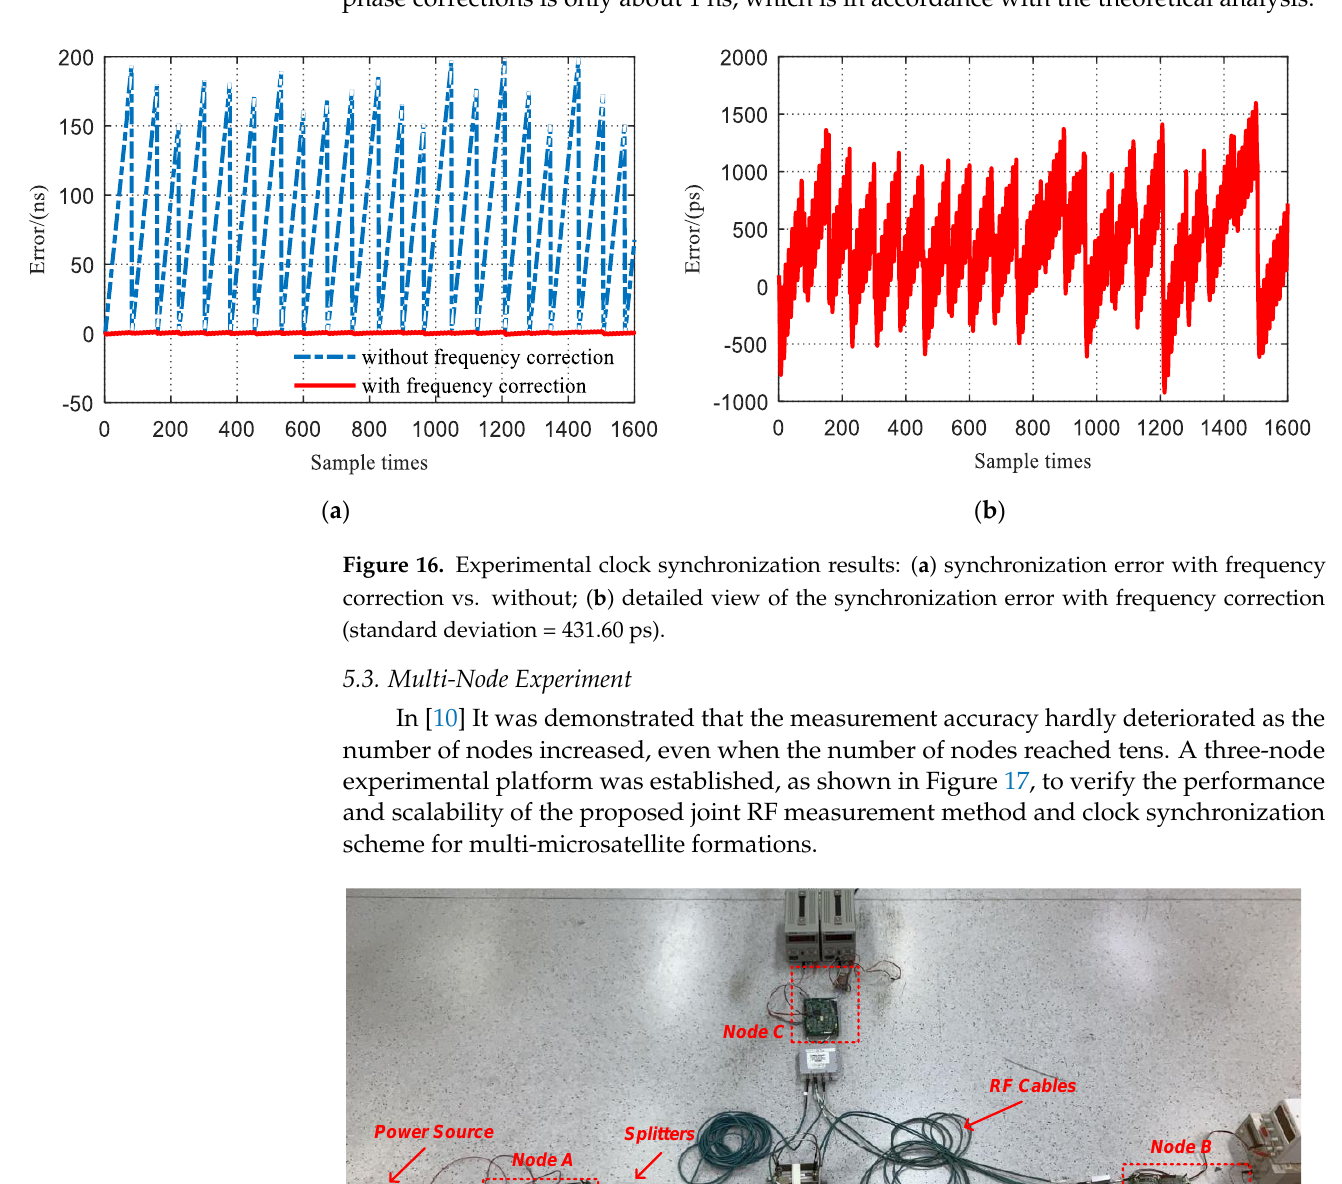
Figure 17. Experimental platform.